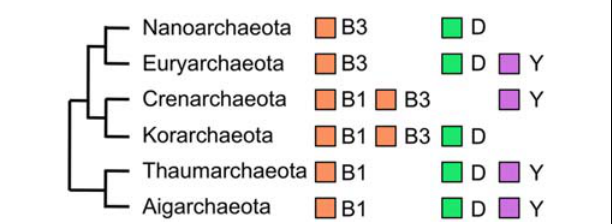
FIGURE 4 | DNA polymerases inArchaea. The evolutionary relationships of six phyla in the domain Archaea are schematically shown with the DNA polymerases encoded in their genomes.The family B DNA polymerases from extrachromosomal elements were